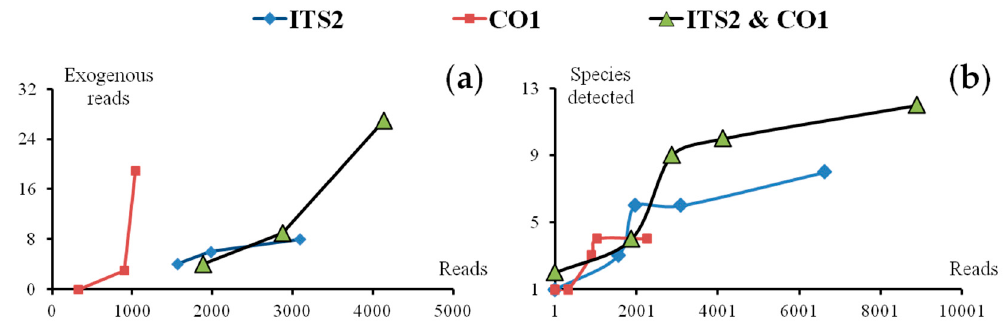
Figure 6. Number of exogenous reads and exogenous species rise along with the increasing of sequencing depth. ( a ) Relations between exogenous reads and total resulting reads. ( b ) Relations between species detected and total resulting reads. ITS2: the second internal transcribed spacer of nuclear ribosomal DNA), CO1: cytochrome c oxidase subunit 1.